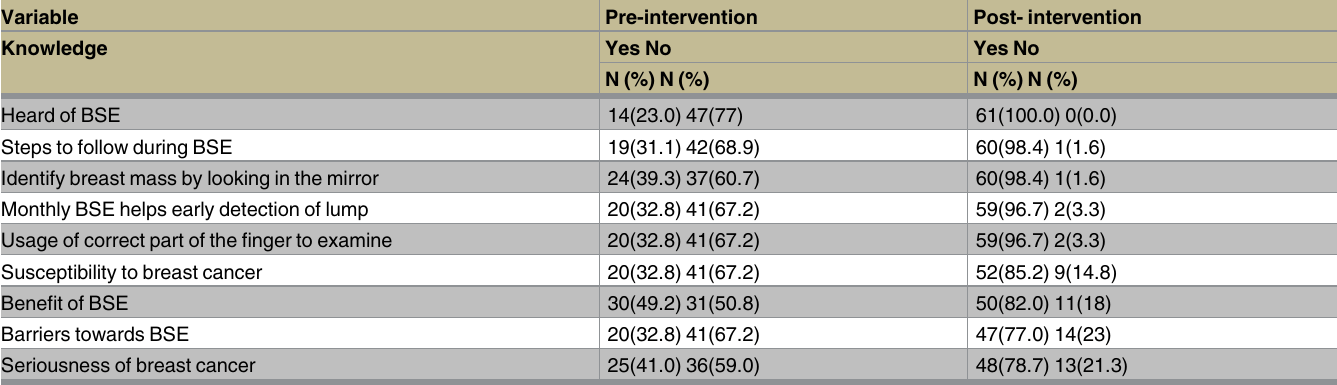
Table 1. Knowledge score on breast self-examination among respondents before and after the intervention, in HawassaHealth Science College, 2015 (N = 61). Variable Pre-intervention Post-